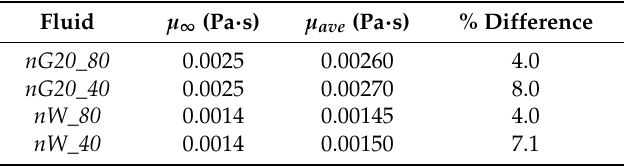
Table 2. Average and asymptotic viscosity for the liquids tested.